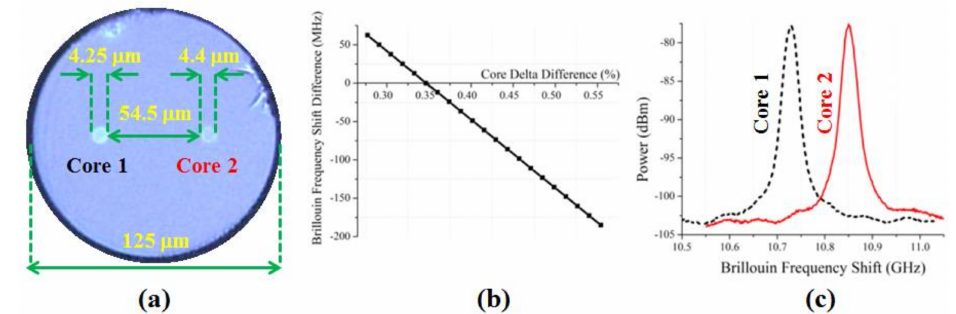
Figure 1. ( a ) Cross-section of multicore optical fiber that has two cores (cores 1 and 2) as described in the text; ( b ) theoretical calculation of the difference between the frequency shifts of cores 1 and 2 as a function of the difference between their deltas as described in the text; ( c ) measured frequency shifts of cores 1 and 2 as described in the